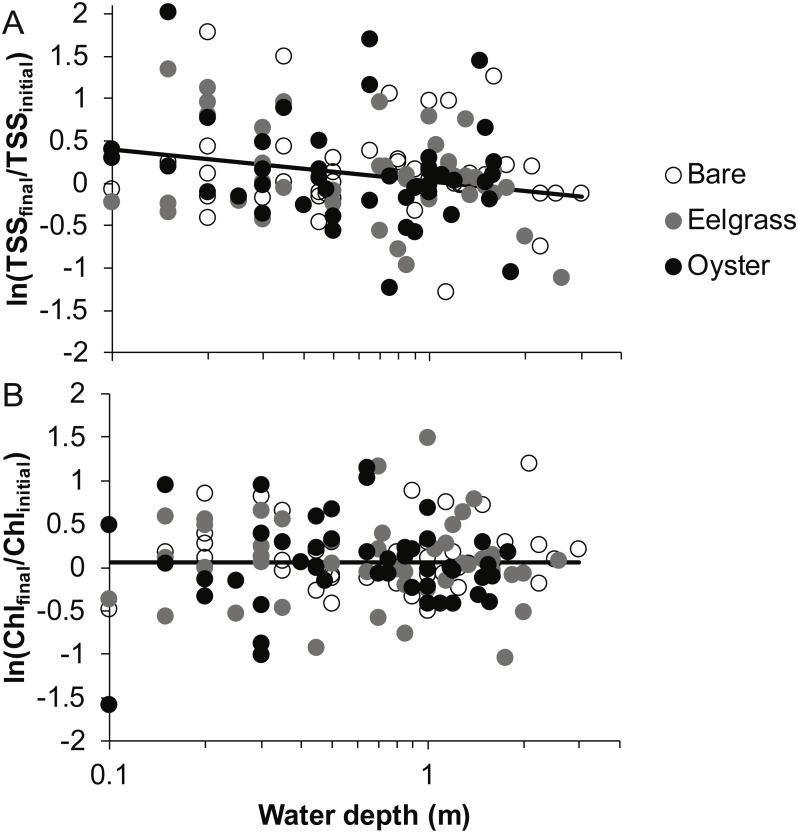
Change in water properties during drifts when water was at different depths over three intertidal habitat types at five sites in Washington State, USA.(A) Change in total suspended solids, based on the log-ratio. (B) Change in chlorophyll-a, based on the log-ratio. Lines are plotted from the coefficients of linear mixed effects models including factors significant at α < 0.05; habitat was not significant in these models, so a single relationship is shown.